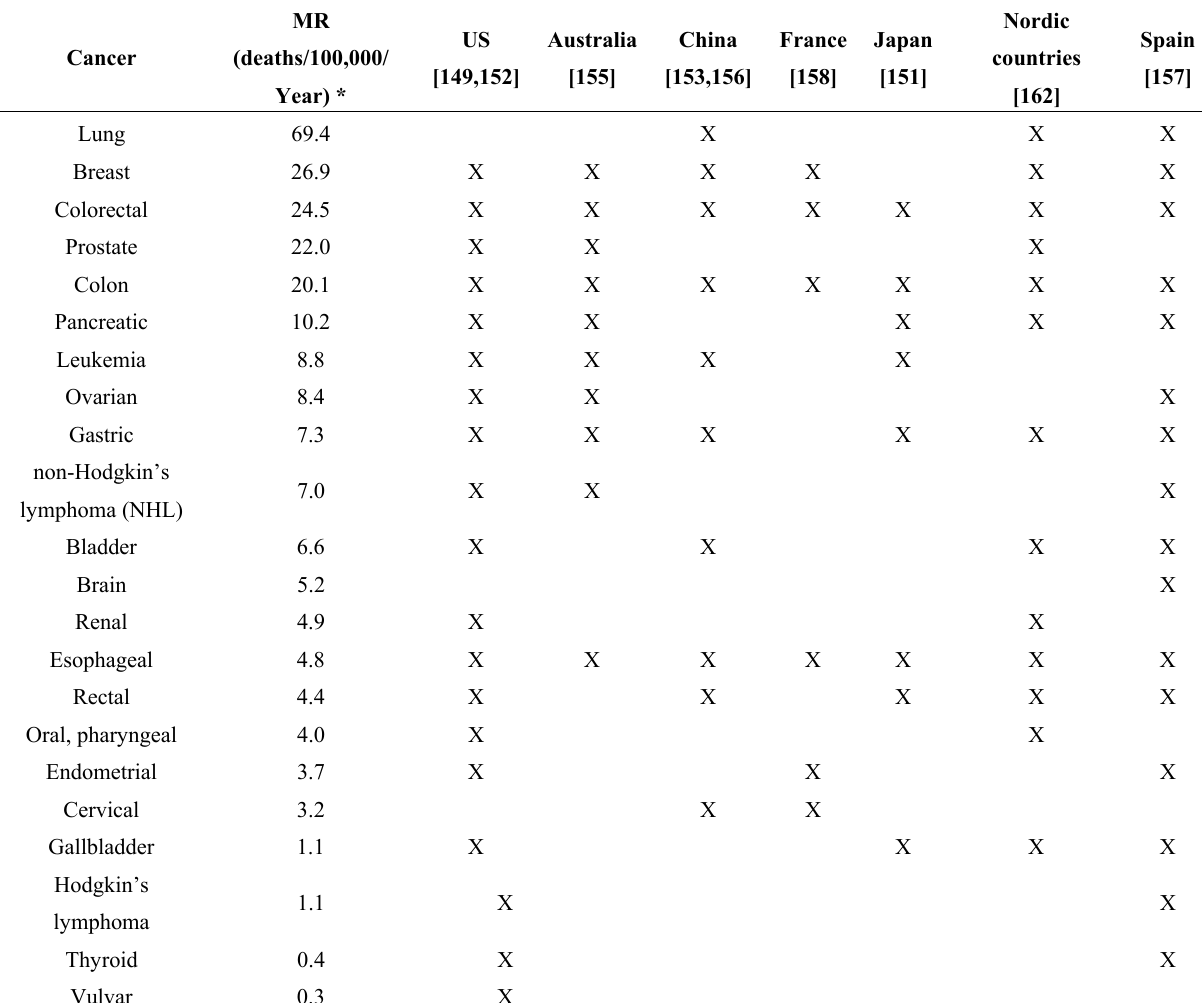
Table 2. Cancers for which inverse correlations between incidence and/or mortality rates (MRs) were found with respect to indices of solar UVB dose in single-country studies (references to be